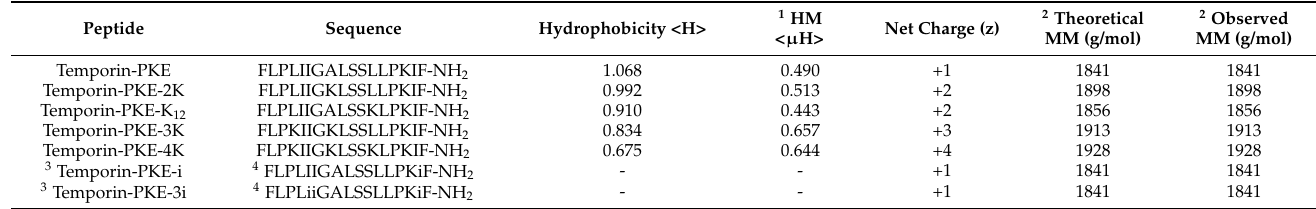
Table 2. The physicochemical properties of temporin-PKE and its analogues. Peptide